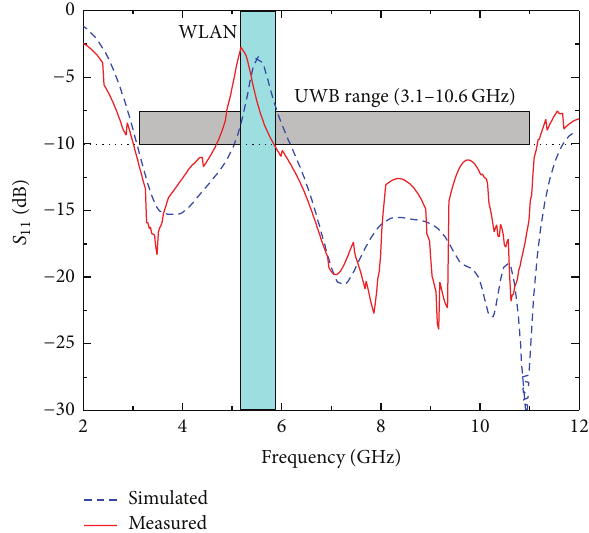
Figure 12: Simulated and measured results of 𝑆 11 of the UWB integrated EBGs with WLAN band notched antenna.